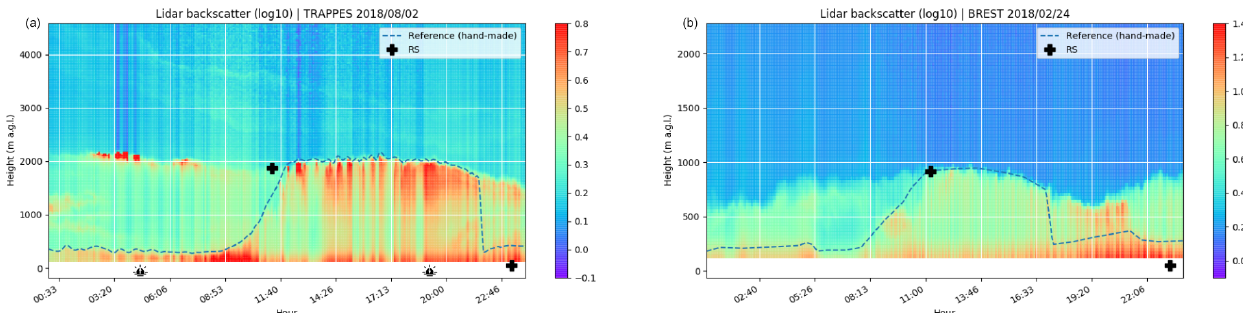
Figure 4. Hand-drawn reference classification and radiosonde estimates overlaying the lidar range-corrected signal for two dates: 2 Au- gust 2018 at the Trappes site (a) and 24 February 2018 at the Brest site (b)